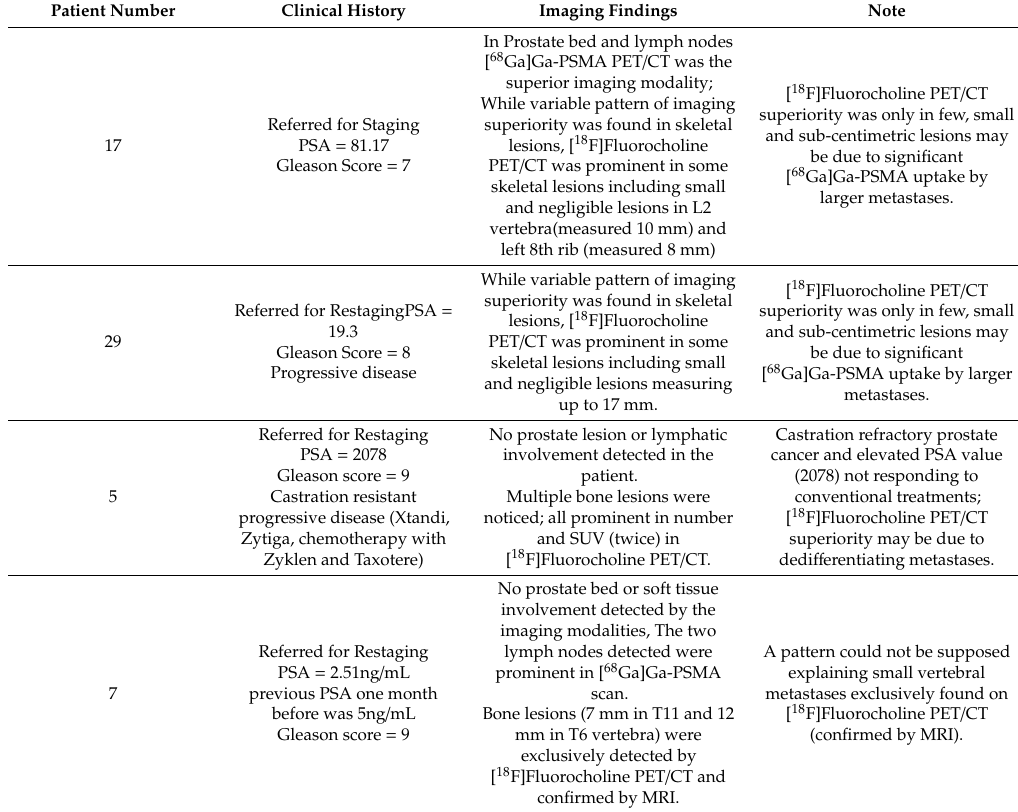
Table 5. Discrepant skeletal lesions exclusively detected by [ 18 F]Fluorocholine PET / CT; 13.3% of all skeletal